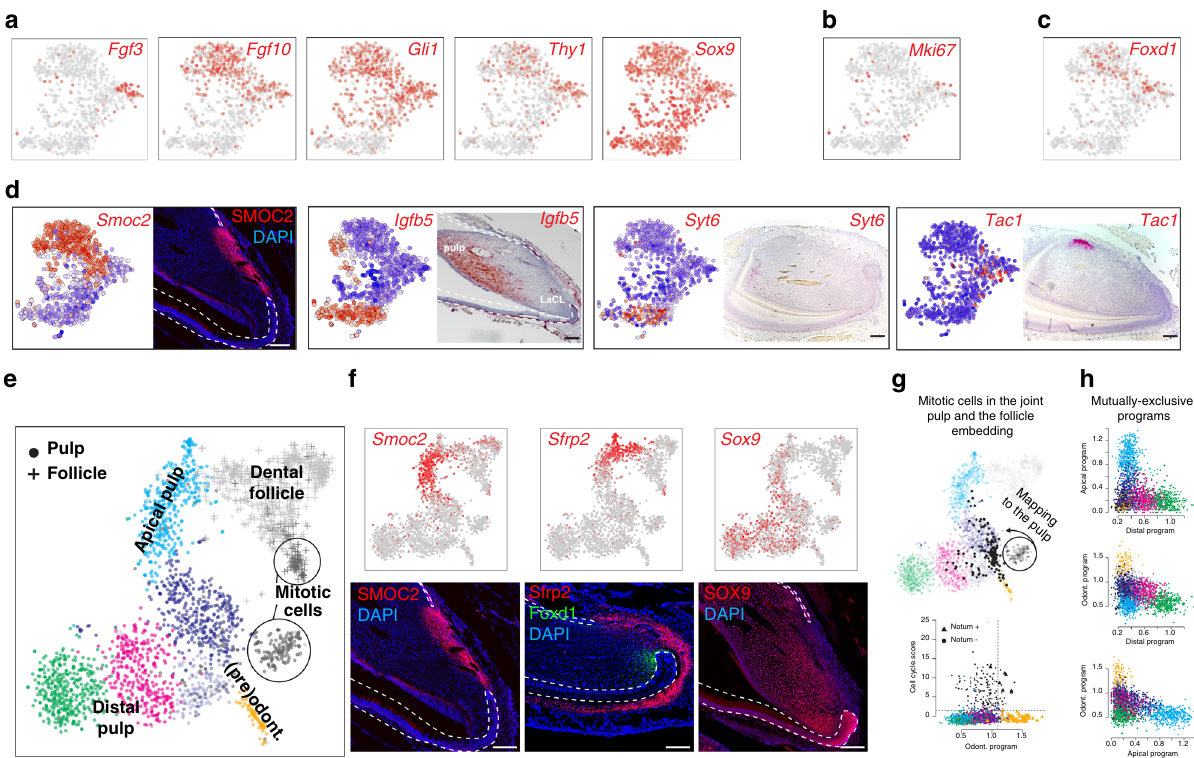
Fig. 6 Portrait of transcriptional heterogeneity in dental mesenchymal populations. a t-SNE representations of selected, previously known marker genes. b t-SNE representation showing position of Mki67 + cells. c t-SNE representation showing position of Foxd1 + cells. d Immunohistochemistry (SMOC2) and in situ hybridization ( Igfbp5, Syt6, and Tac1 ) characterization of key populations in the mesenchymal population. Importantly, Igfbp5 and Syt6 demarcate more distal pulp and Tac1 is a unique marker for dental pulp attached to the lingual cervical loop. e Landscape of mesenchymal cells of dental pulp (dots) and follicle (crosses) is reproduced and extended with 10× Chromium. t-SNE embedding shows 2552 mesenchymal cells grouped in clusters, where clusters colours re fl ect colours of annotated Smart-seq2 pulp clusters (see Fig. 3a). Of note, cells from apical pulp gradually extend into cells of dental follicle. f Experimental validations of gradual spatio-transcriptional gradient from apical pulp to dental follicle. Immunohistochemistry of SMOC2 highlights the position of the apical pulp state, corroborated by Smart-seq2 and 10× Chromium single-cell datasets. In situ hybridization of Sfrp2 , consistent